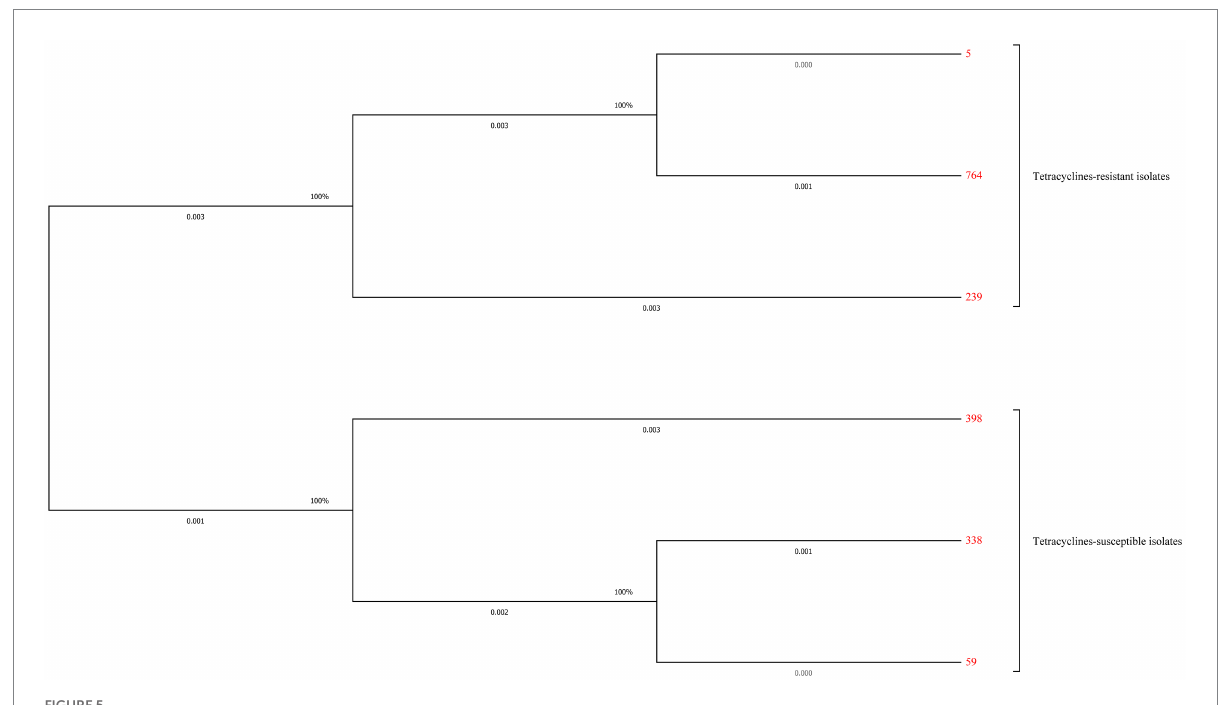
FIGURE 5 Maximum-likelihood trees of 41 tetracyclines-resistant and 10 tetracyclines-susceptible Staphylococcus aureus isolates based on the concatenated sequences of MLST. Tetracyclines-resistant and-susceptible isolates were divided into two major branches. ST5 ( n = 30), ST764 ( n = 9), and ST239 ( n = 1) were seen in the tetracyclines-resistant isolates, and ST59 ( n = 4), ST398 ( n = 2), and ST338 ( n = 1) were observed in tetracyclines-susceptible